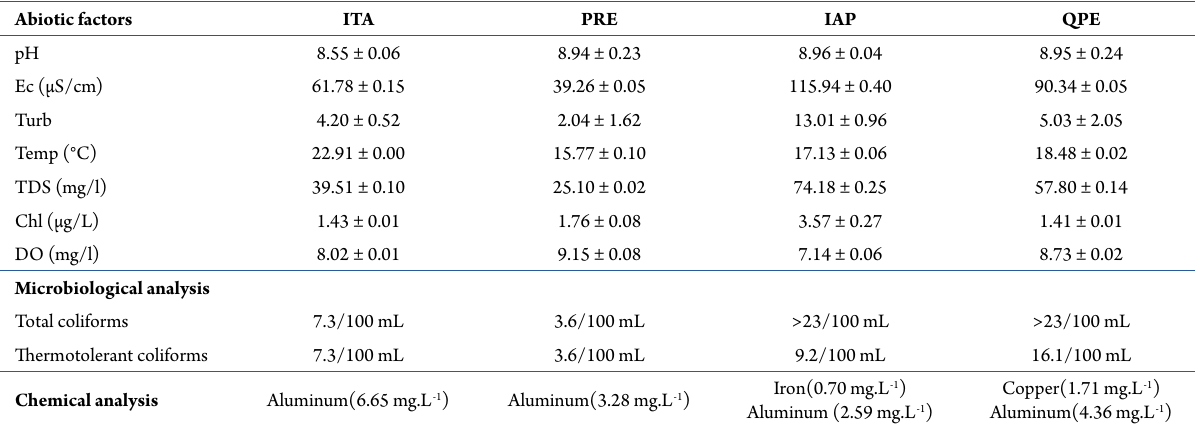
Table 2. Abiotic factors (mean ± standard deviation), water quality, microbiological and chemical analysis in ITA (São Paulo State) and PRE, IAP and QPE (Paraná State), Brazil. Legend of abiotic factors: pH, Ec (Conductivity), Turb (Turbidity), Temp (Temperature), TDS (Total dissolved solids), Chl (Chlorophyll), DO (Dissolved oxygen). ITA: Itaúna stream, PRE: Preto stream, IAP: Iapó stream, QPE: Quebra Perna